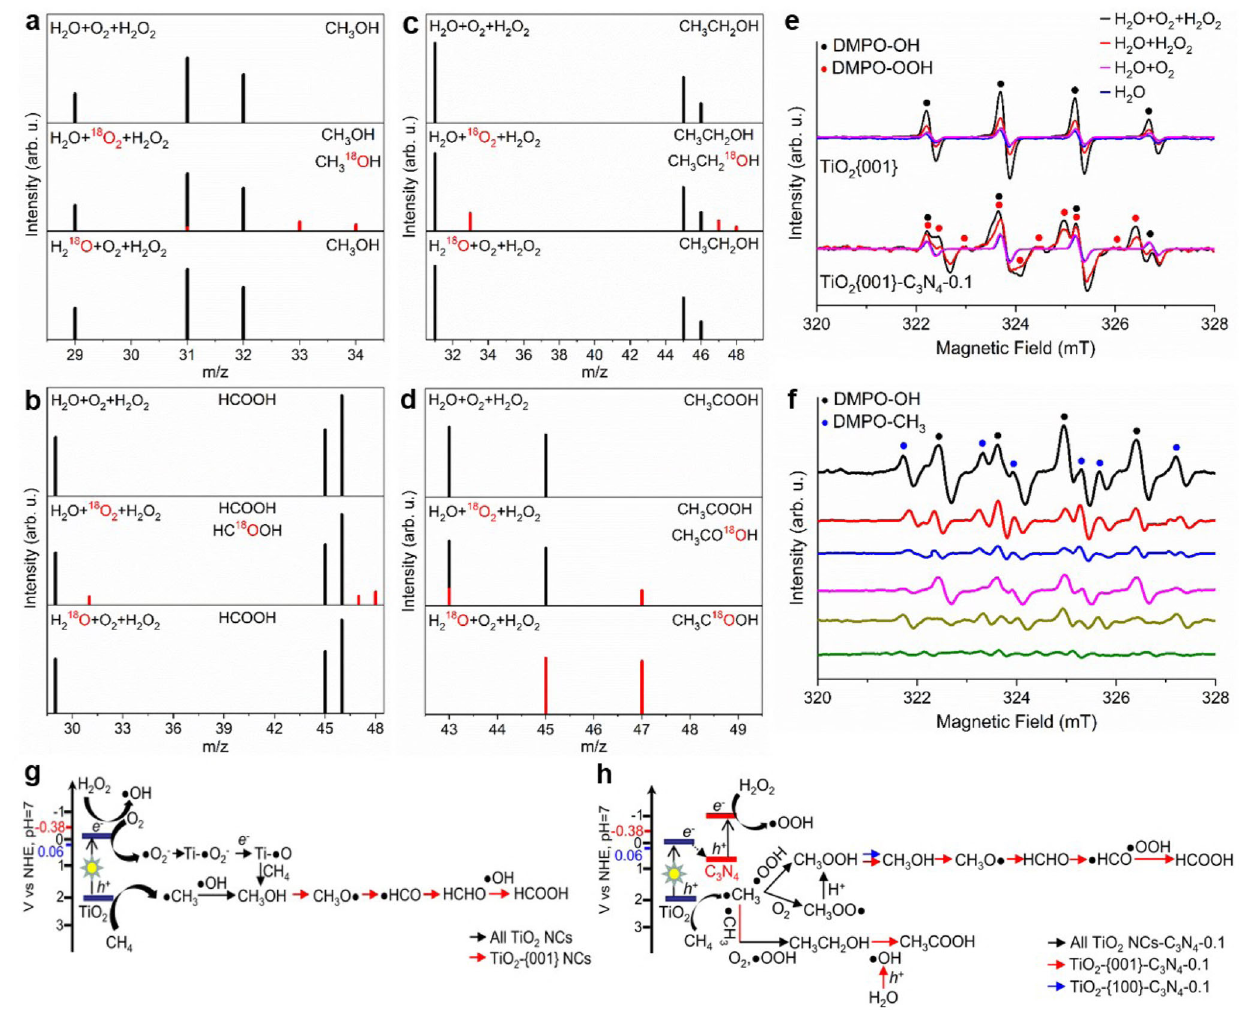
Fig. 2 | Reaction mechanism. Mass spectra of ( a ) methanol, ( b ) formic acid, ( c ) ESR spectra of CH 4 +H 2 O mixture under UV light illumination at 298K in the pre- ethanol and ( d ) acetic acid formed during photocatalytic CH 4 conversion over sence of DMPO over TiO 2 {101} (olive), TiO 2 {100} (dark yellow) and TiO 2 {001} TiO 2 {001}-C 3 N 4 − 0.1 under the reaction condition of 8%CH 4 +4%O 2 +88%Ar+165 (magenta)NCs,TiO 2 {101}-C 3 N 4 − 0.1(blue),TiO 2 {100}-C 3 N 4 − 0.1(red)andTiO 2 {001}- μ L H μ L H C 3 N 4 − 0.1 (black) composites. Schematic diagrams of proposed dominant photo- 2 O 2 +20mL H 2 O, 8%CH 4 +4% 18 O 2 +88%Ar+165 2 O 2 +20mL H 2 O, or 8% CH 4 +4%O 2 +88%Ar+165 μ L H 2 O 2 +20mL H 2 18 O. Photocatalyst amount: 20mg; catalytic aqueous-phase CH 4 reaction paths to liquid-phase oxygenates in the reaction temperature: 25°C; reaction time: 8h. e In situ ESR spectra of H 2 O, presenceofH 2 O 2 andO 2 over( g )TiO 2 NCsand( h )TiO 2 NCs-C 3 N 4 .The0.06eVand − 0.38eV refer to the redox potential of H H 2 O+O 2 , H 2 O+H 2 O 2 and H 2 O+O 2 +H 2 O 2 solutions underUV light illumination at 2 O 2 activated to ·OH radicals and ·OOH 298KinthepresenceofDMPOoverTiO 2 {001}NCsandTiO 2 {001}-C 3 N 4 − 0.1. f Insitu radicals at pH=7. Source data are provided as a Source Data fi